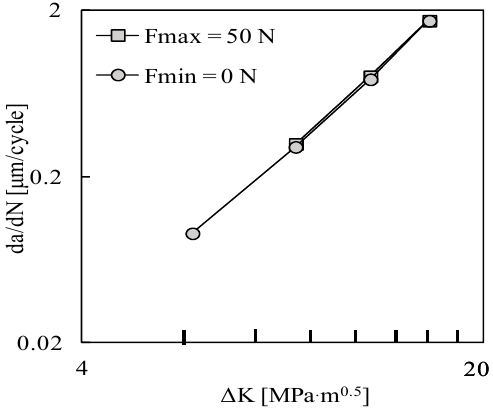
Figure 3. Effect of the constant amplitude loading limits on the FCG rate when the contact of crack flanks is neglected: da/dN versus Δ K .